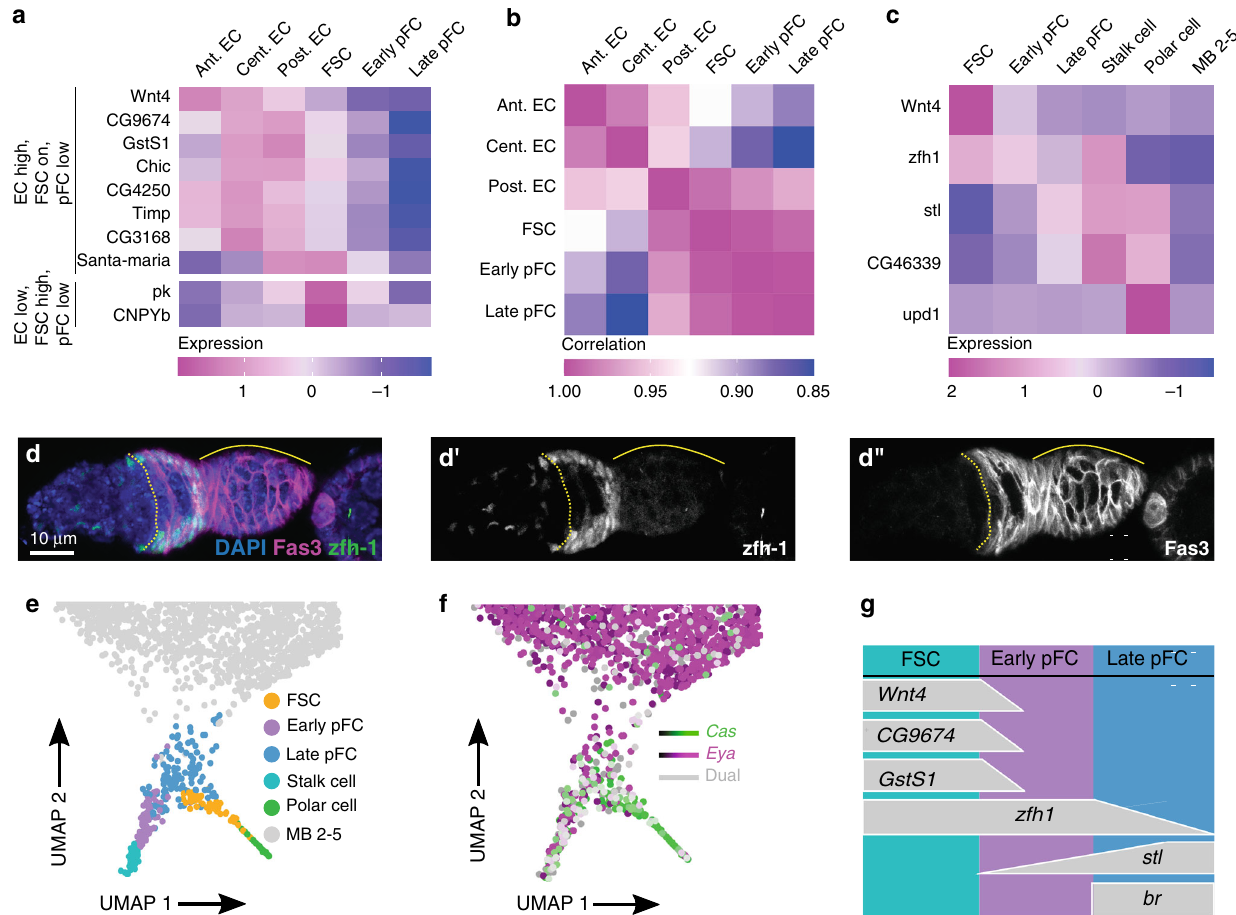
Fig. 6 Distinct expression patterns in cell types of the early follicle cell lineage. a Heat map of gene expression in EC populations, FSCs and pFCs. Most stem cell markers identi fi ed by pseudotime analysis of the early FSC lineage (Fig. 5a) are also expressed in ECs. In contrast, pk and CNPYb show high expression on FSCs but not ECs and pFCs. b Heat map showing the correlation in the gene expression pro fi les of EC, FSC and pFC clusters. We observe a high degree of similarity between cell types of the same lineage, as expected, but also fi nd that the gene expression pro fi le of pECs has substantial overlap with FSCs and pFCs. c Heat map showing the expression of markers that can be used to distinguish FSCs, early pFCs, late pFCs and stalk and polar cells from each other. d Maximum intensity projection of a wildtype germarium stained for zfh1 (green), Fas3 (magenta), and DAPI (blue). d ’ zfh1 staining (white). d ” Fas3 staining (white). e – f UMAP plots showing FSC, pFC, stalk and polar cell clusters ( e ) and the expression patterns of cas and eya ( f